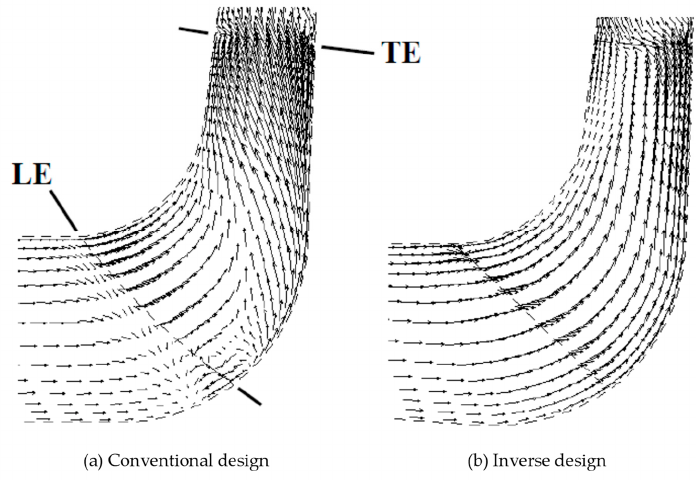
Figure 7. Velocity vectors on the blade suction surface [10].